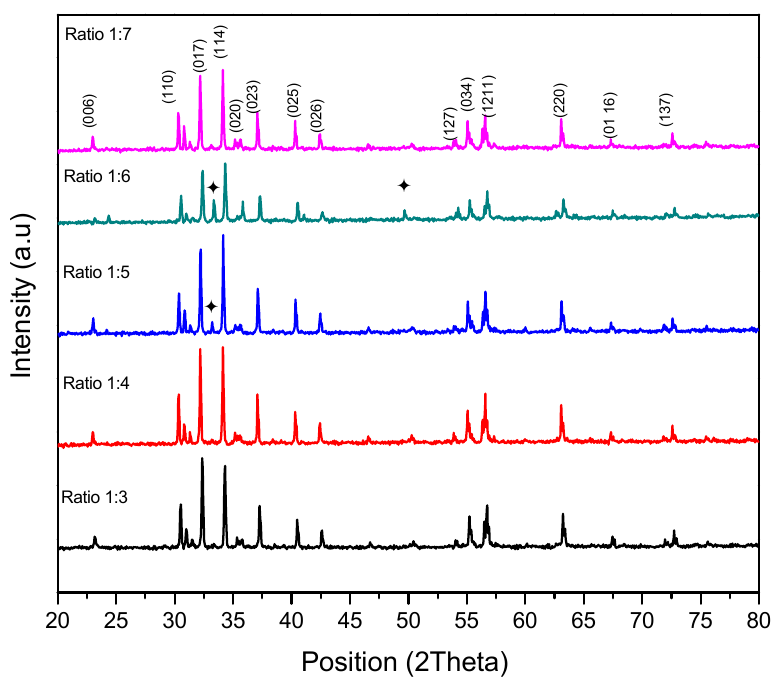
Figure 1. X-ray diffraction pattern for BaFe 12 O 19 at different ratios of ammonium nitrate.